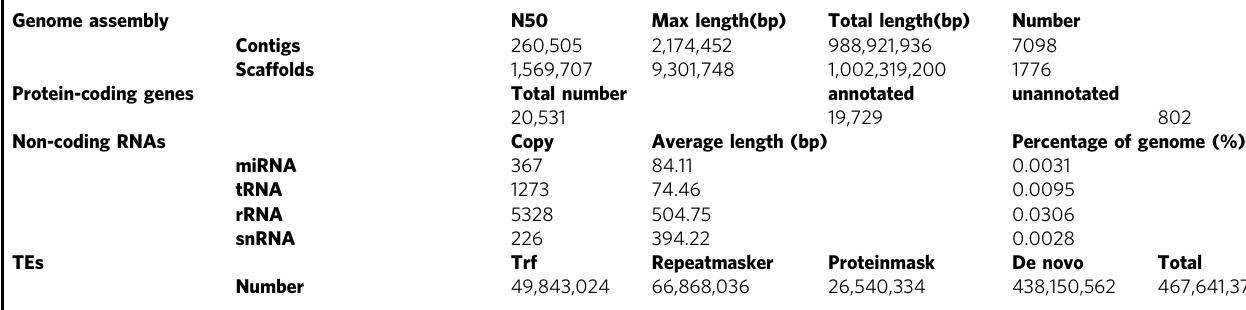
Table 1 Statistical analysis of the genome-assembly results. Genome